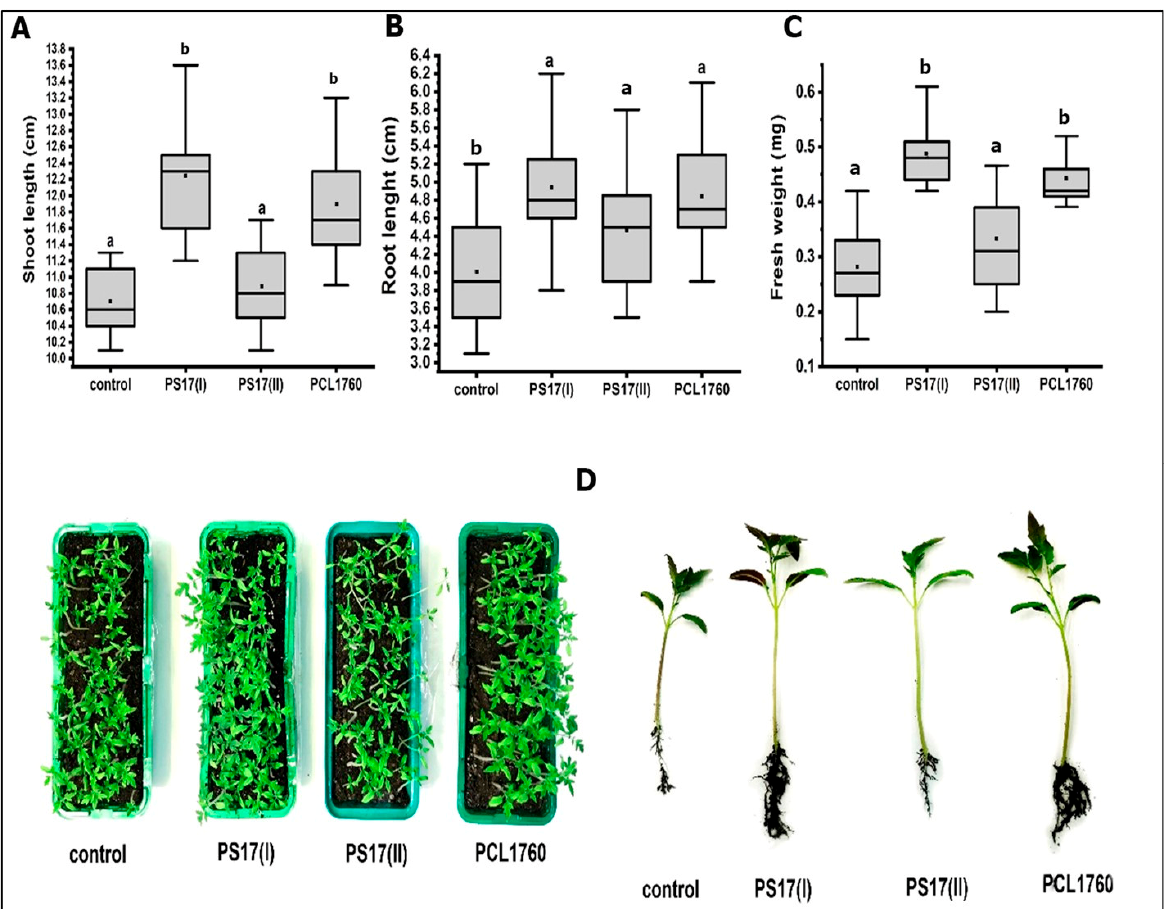
Figure 10. Plant growth-promoting activity of B. mojavensis PS17 morphotypes on ( A ) shoots, ( B ) roots, and ( C ) fresh weight of tomato plants. ( D ) Photo recording tomato plant growth 3 weeks after seed sowing. The experiment was performed in triplicate and repeated twice. Statistical differences at p -value < 0.05 between groups are indicated by different letters.